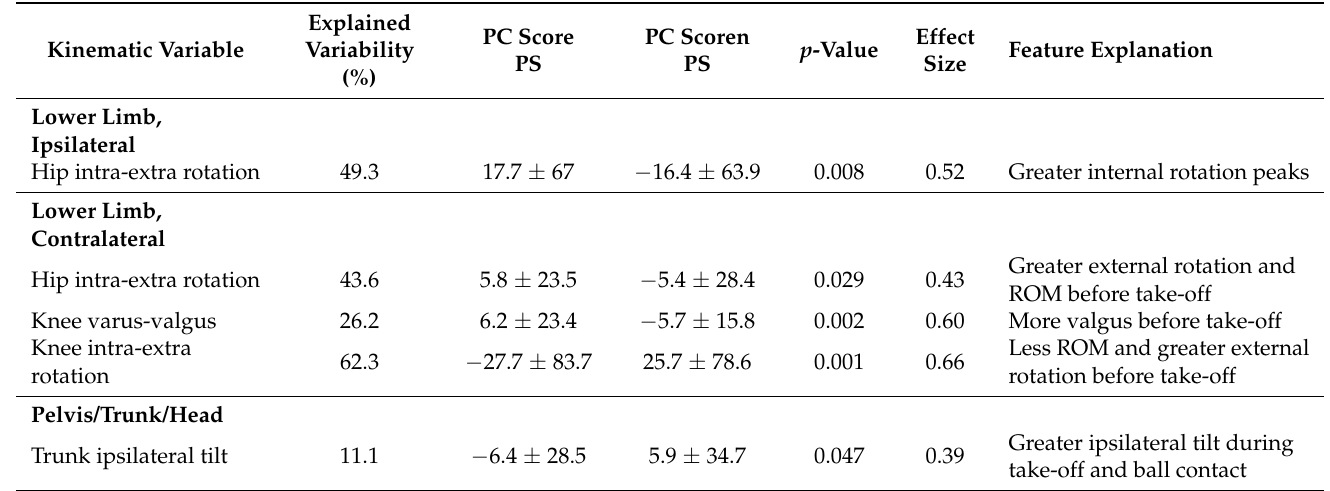
Table 5. Principal Components differences in High Dive